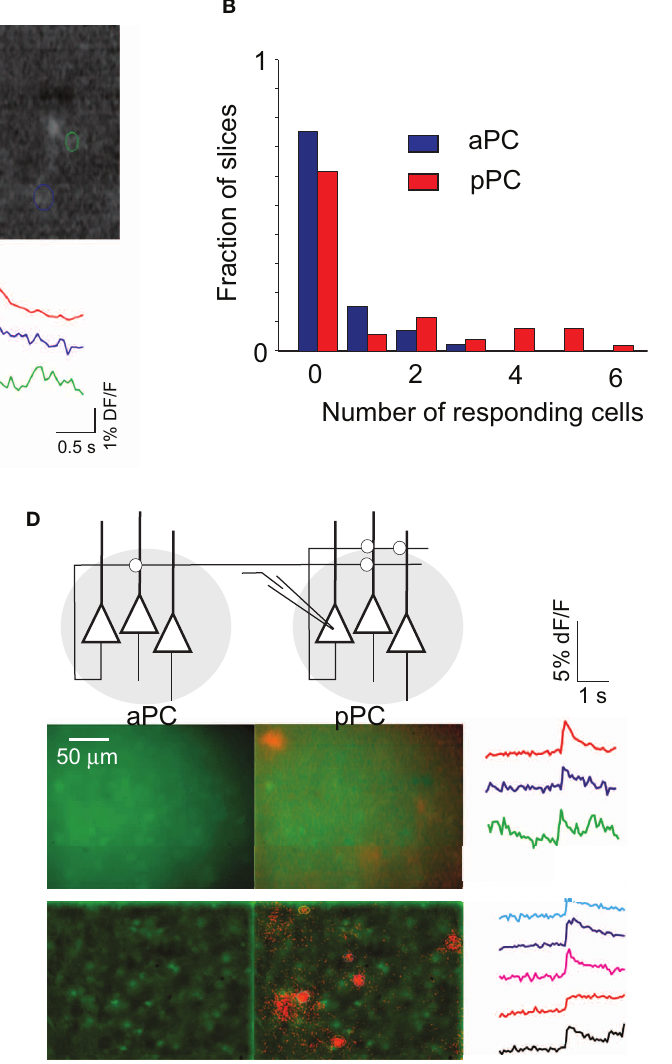
FIGURE 8 | Connectivity in the pPC. (A) Example of a group of cells in pPC labeled with OGB-1 (green), along with the response image when a single neuron was stimulated (grayscale image). The response image was obtained by taking the difference of 10 frames each after and before stimulation. The bright cell to the top left of the image is the stimulated neuron. The two images are superimposed at bottom left (with response image colored red), and the fluorescence traces for the three responding cells are shown at bottom right. (B) The distribution of the number of responding cells from all the experiments is shown for pPC (red). Similar data for the aPC (blue) are shown for comparison. (C) Experiments